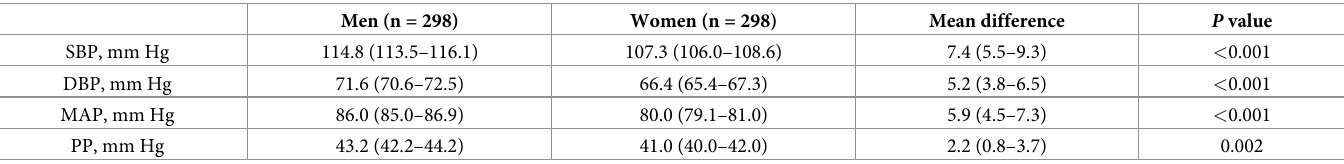
Data are estimated marginal means (95% CIs). Nonstandard abbreviations and acronyms as in Table